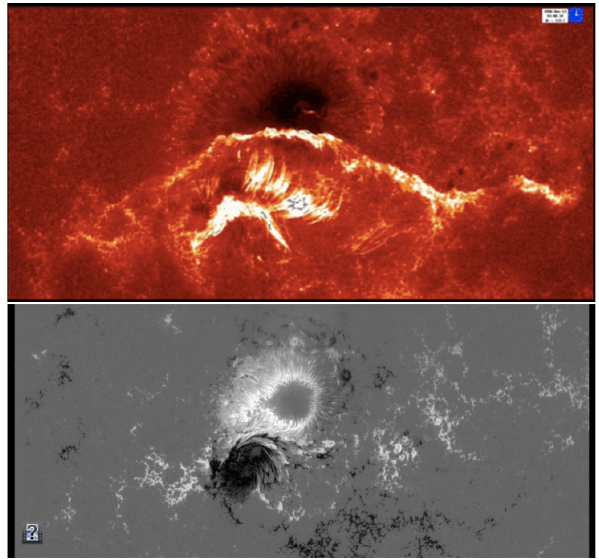
Fig. 21. In this sunspot pair, the negative spot rotated during a flare on 13 December 2006 (courtesy of K.